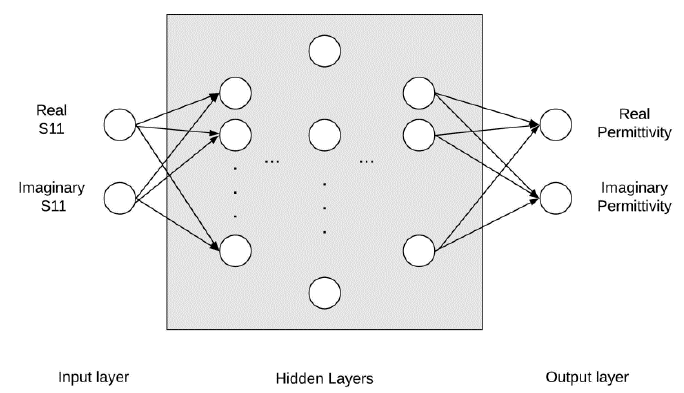
Figure 3. The ANN architecture showing the input layer which is composed of both the real and imaginary S11 as inputs. They grey box encapsulates the five hidden layers which have, respectively from left to right, 200, 400, 600, 400, 200 nodes. The output layer is made up of the real and imaginary permittivity as two distinct outputs.